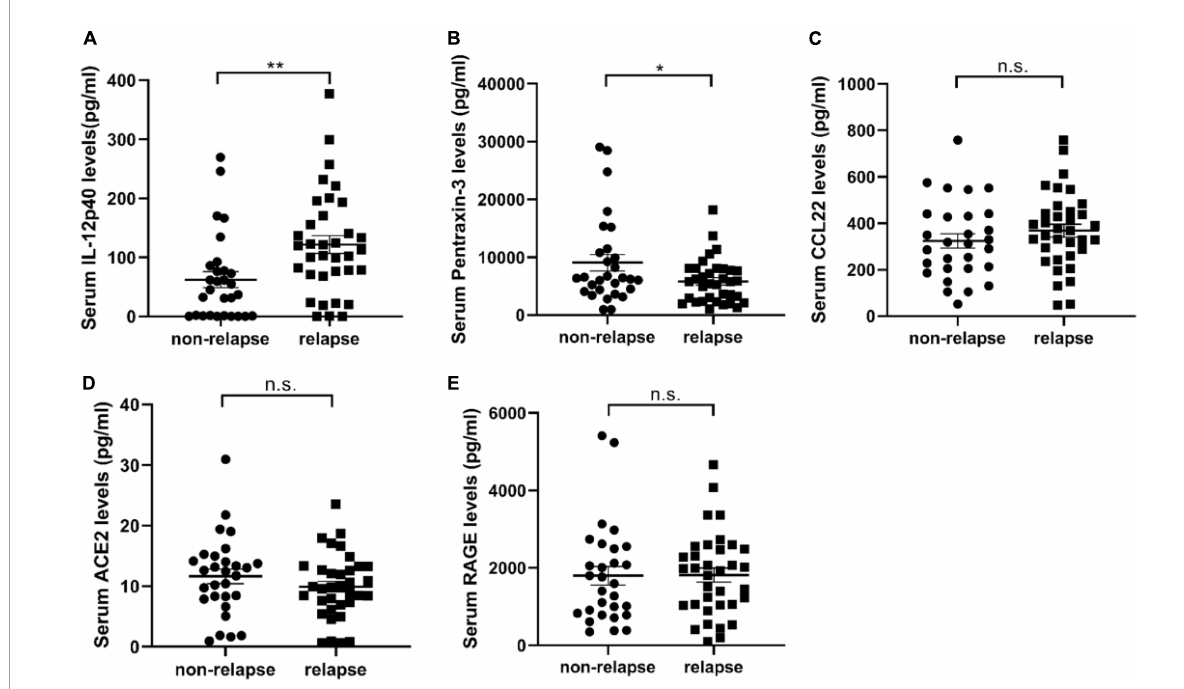
FIGURE2 The validation results of serum cytokine antibody microarray by enzyme-linked immunosorbent assay (ELISA). (A–E) Show the expression of IL-12p40, pentraxin-3, CCL22, ACE, and RAGE in the serum samples of 35 relapsed and 29 non-relapsed minimal change disease (MCD) patients. The expression of IL-12p40 in the relapsed group was 121.7 ± 14.71 pg/ml, and the expression in the non-relapsed group was 62.46 ± 13.52 pg/ml ( P = 0.005). The expression of pentraxin-3 in the relapsed group was 5817 ± 639.2 pg/ml, and the expression in the non-relapsed group was 9080 ± 1406 pg/ml ( P = 0.029). The expression of CCL22 ( P = 0.2965), ACE ( P = 0.2527), and RAGE ( P = 0.9565) in the serum samples of relapsed and non-relapsed groups showed no significant differences. * P < 0.05; ** P < 0.01; n.s., not